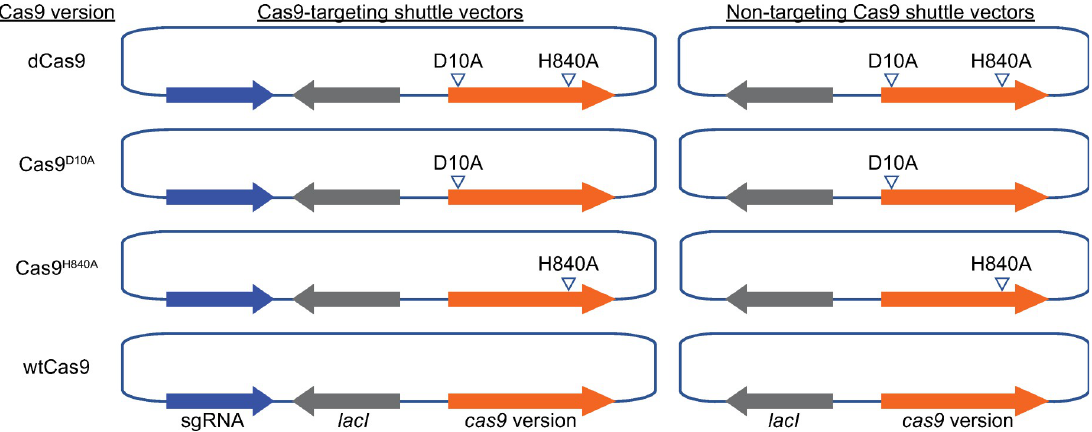
Fig 1. Schematic depiction of E . coli / B . burgdorferi shuttle vectors used in this study. Left, all-in-one, Cas9-targeting shuttle vectors carrying a sgRNA expression cassette as well as an IPTG-inducible Cas9 expression cassette that contains a constitutively expressed lacI gene. Right, non-targeting Cas9 shuttle vectors, which lack the sgRNA cassette. The Cas9 versions used are, from top to bottom: dCas9, Cas9 D10A , Cas9 H840A , and Cas9 WT . The dCas9 shuttle vectors were previously described [52]. Presence of the D10A or H840A mutation is indicated by arrowheads. Features are not drawn to scale. For simplicity, other important features of the shuttle vectors, such as the antibiotic resistance cassette or the E . coli or B . burgdorferi origins of replication, are not marked on the